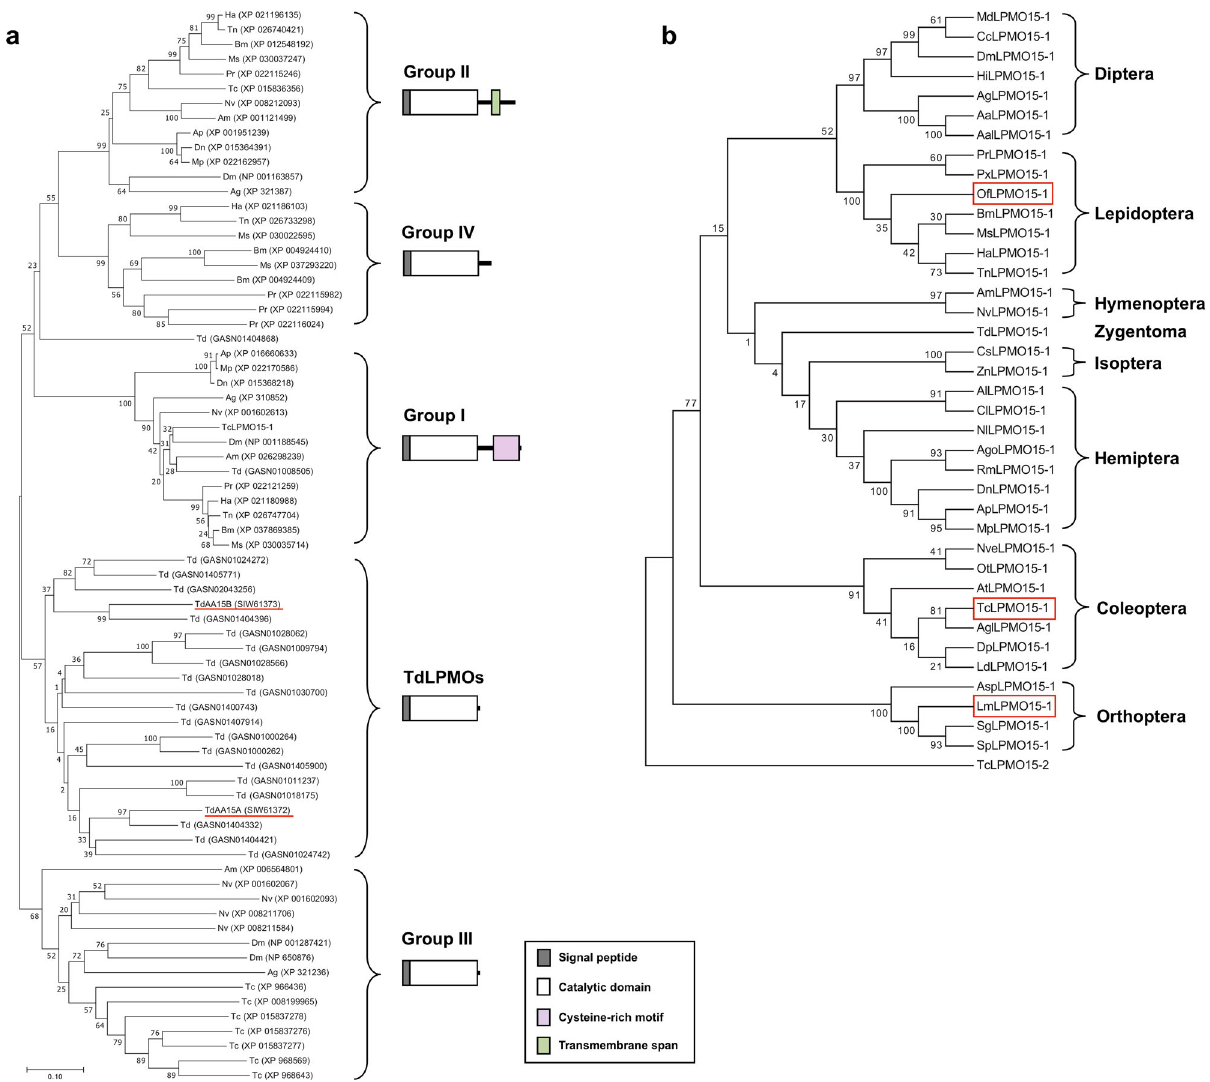
Fig. 1 Phylogenetic analysis of insect LPMO15s. a Phylogenetic tree of putative LPMO15s from T. castaneum and other insect species whose genomes have been sequenced and annotated. Tc, Tribolium castaneum ; Dm, Drosophila melanogaster ; Ag, Anopheles gambiae ; Am, Apis mellifera ; Nv, Nasonia vitripennis ; Bm, Bombyx mori ; Ms, Manduca sexta ; Ha, Helicoverpa armigera ; Tn, Trichoplusia ni ; Pr, Pieris rapae ; AP, Acyrthosiphon pisum ; Mp, Myzus persicae ; Dn, Diuraphis noxia ; Td, Thermobia domestica . Td AA15A and Td AA15B are underlined. b Phylogenetic tree of insect group I LPMO15s (LPMO15-1s). Amino acid sequences of LPMO15-1 proteins from different insect species were obtained by performing a BlastP search of NCBI database. Tc LPMO15-2 (group II LPMO15) of T. castaneum was used as the outgroup. Phylogenetic trees were constructed by MEGA 7.0 software using the Neighbor-Joining method. See Supplementary Table 3 for the accession numbers of LPMO15-1 proteins used in this